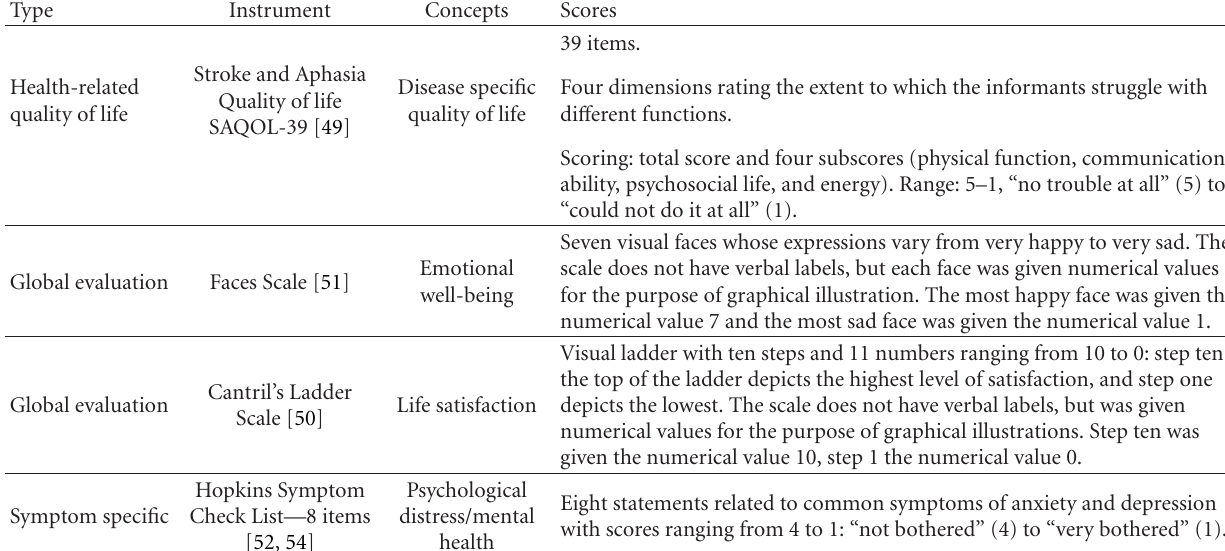
Table 3: Standardized clinical